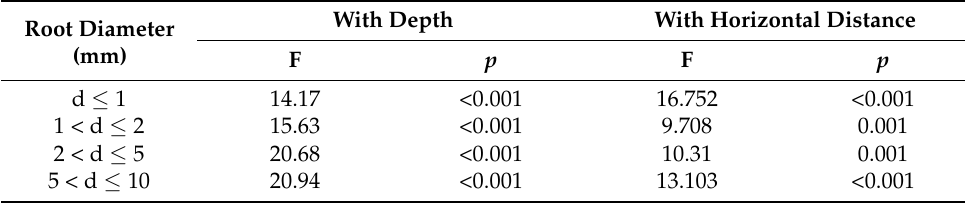
Figure 6. Root distribution along with the horizontal distance from the tree stem (d = root diameter in mm). Table 3. ANOVA test results for roots diameter variation between investigated trees.